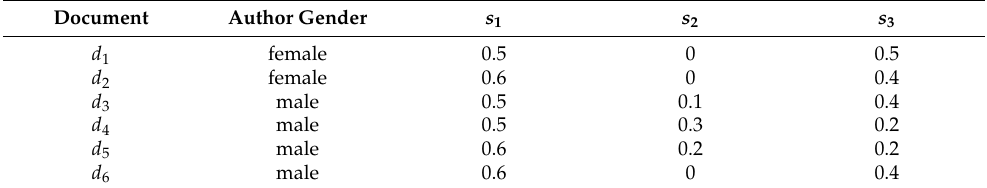
Table 4. Small hypothetical example of a corpus consisting of six documents d 1 , . . . , d 6 with the topics shares s 1 ( d i ) , . . . , s 3 ( d i ) of three topics for each document d i .